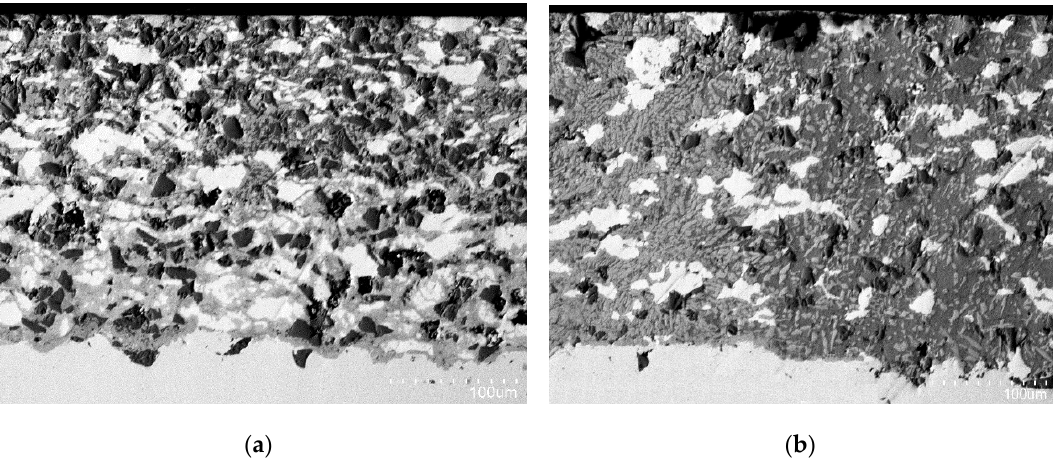
Figure 10. Intermetallics formation in the center ( a ) and at the boundary ( b ) of weld in 49% Al coating heated by resistance spot welding process with parameters No. 4.